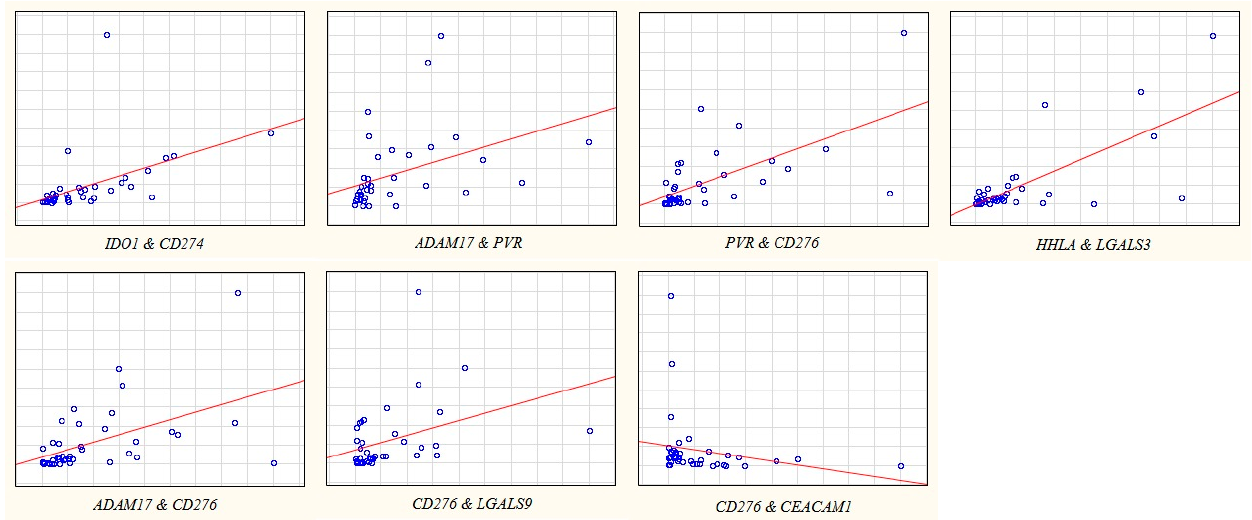
Figure 4. Scatterplot of gene expression at stage I + II (early GC).